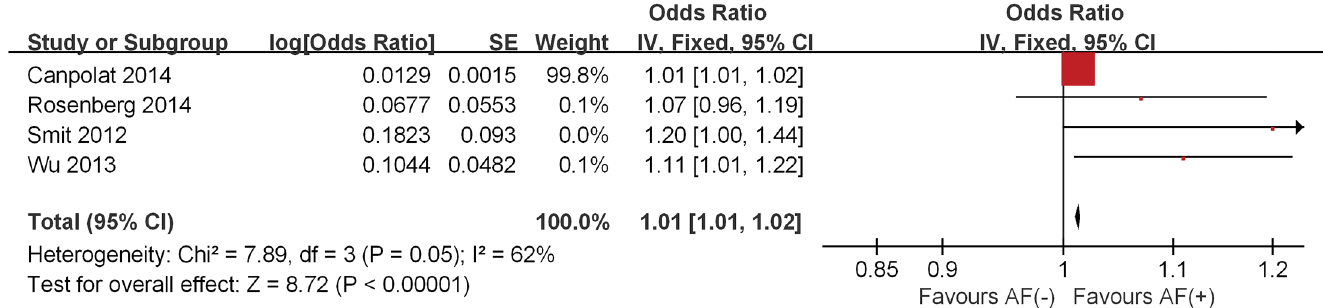
Fig 3. Forest plot of the association between the plasma level of TGF- β 1 and AF occurrence in which TGF- β 1 levels were analyzed as a categorical variable. AF, atrial fibrillation; CI, confidence interval; OR, odds ratio.